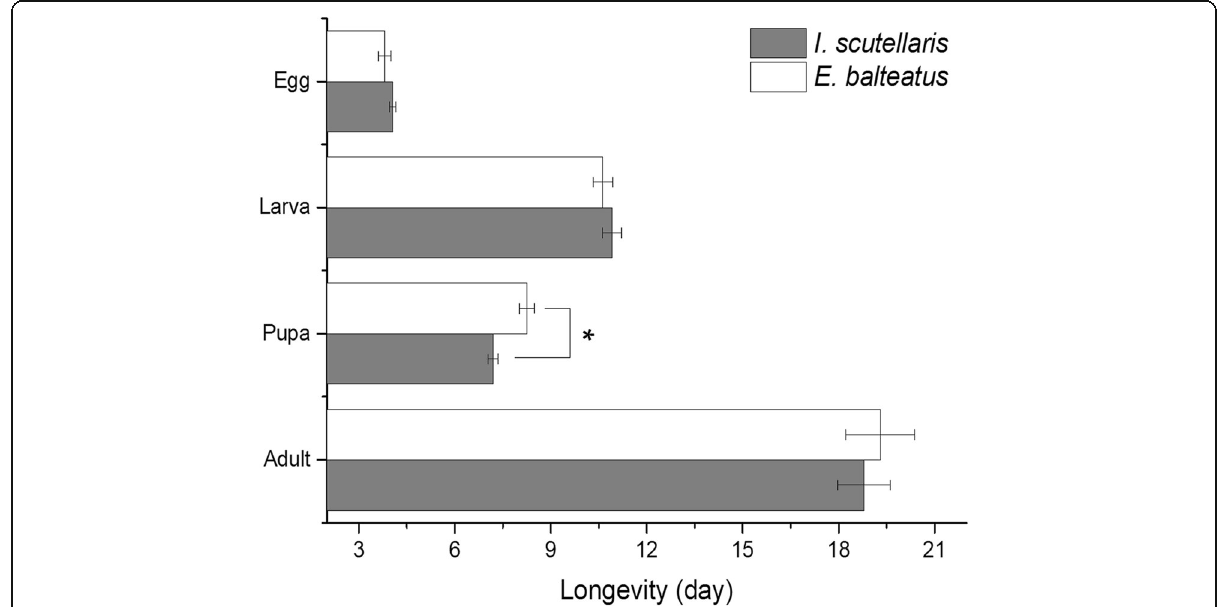
Fig. 3 Comparative developmental times of different life stages of I. scutellaris and E. balteatus . The bars are means ± SEM, and an asterisk above a pair of the bars presents a significant difference between two predator species ( P <